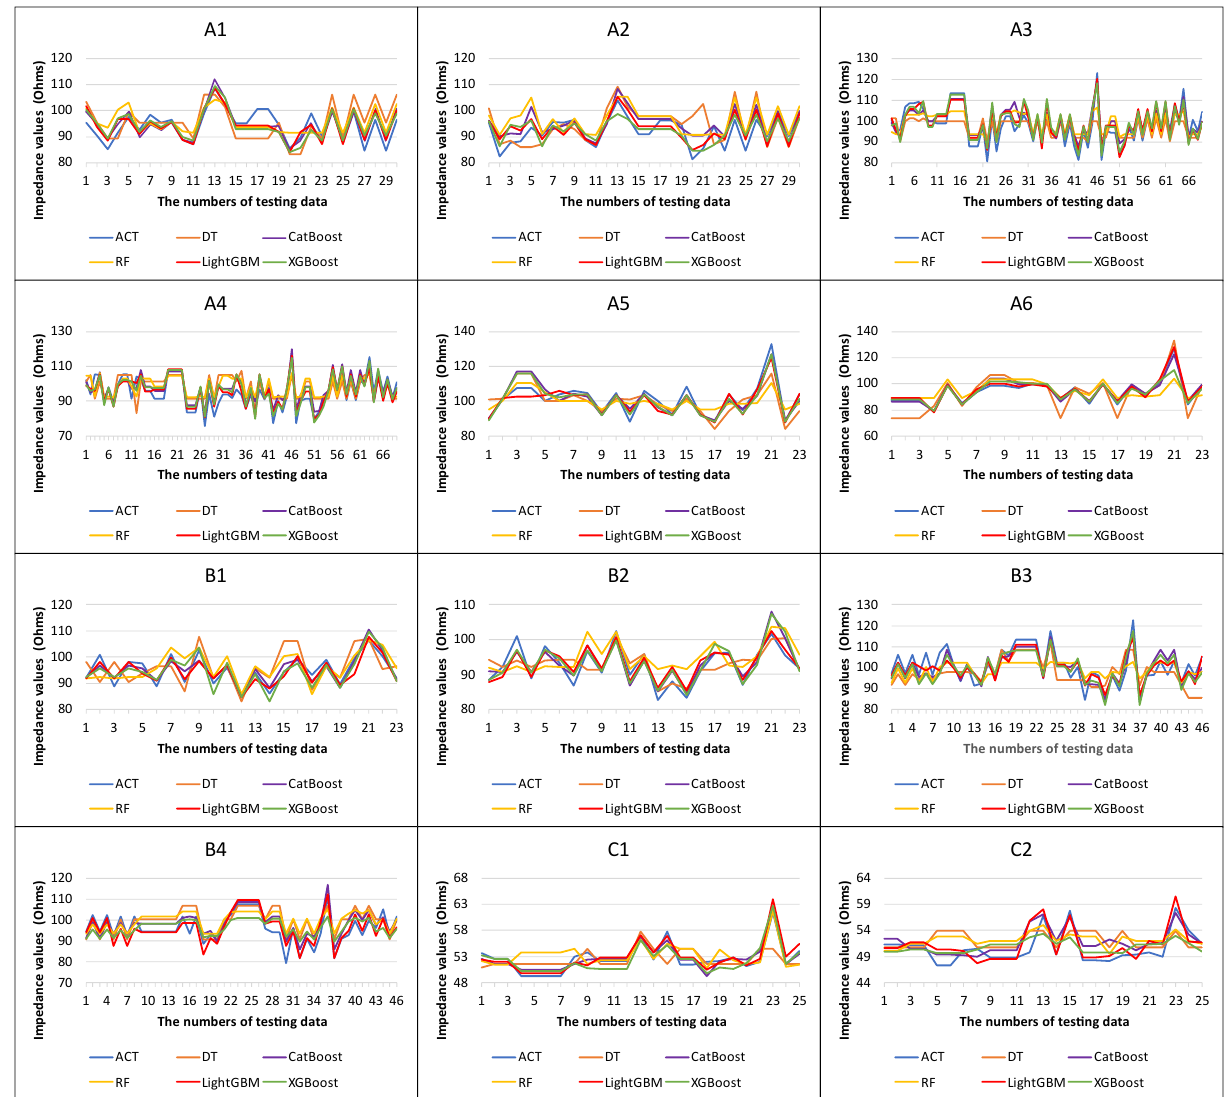
Figure 7. The point-to-point plots of actual and predicted values of impedance for five machine learning models (product A1 – A6, B1 – B4, C1 –